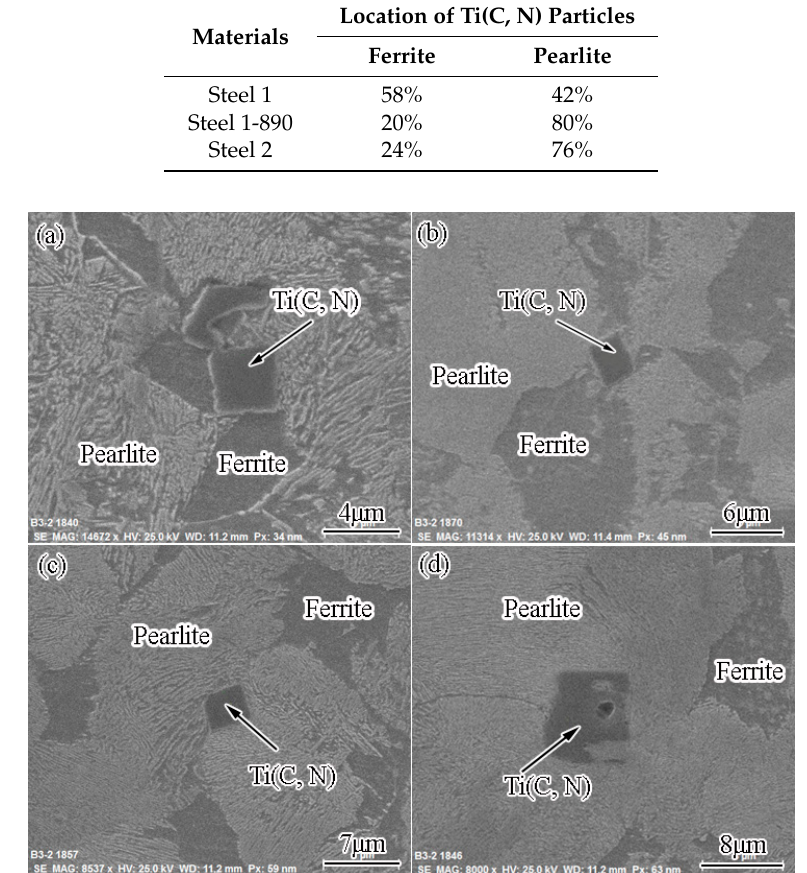
Figure 8. Coarse Ti(C, N) particles located in ferrite ( a ) and pearlite ( b – d ) in steel 1-890.